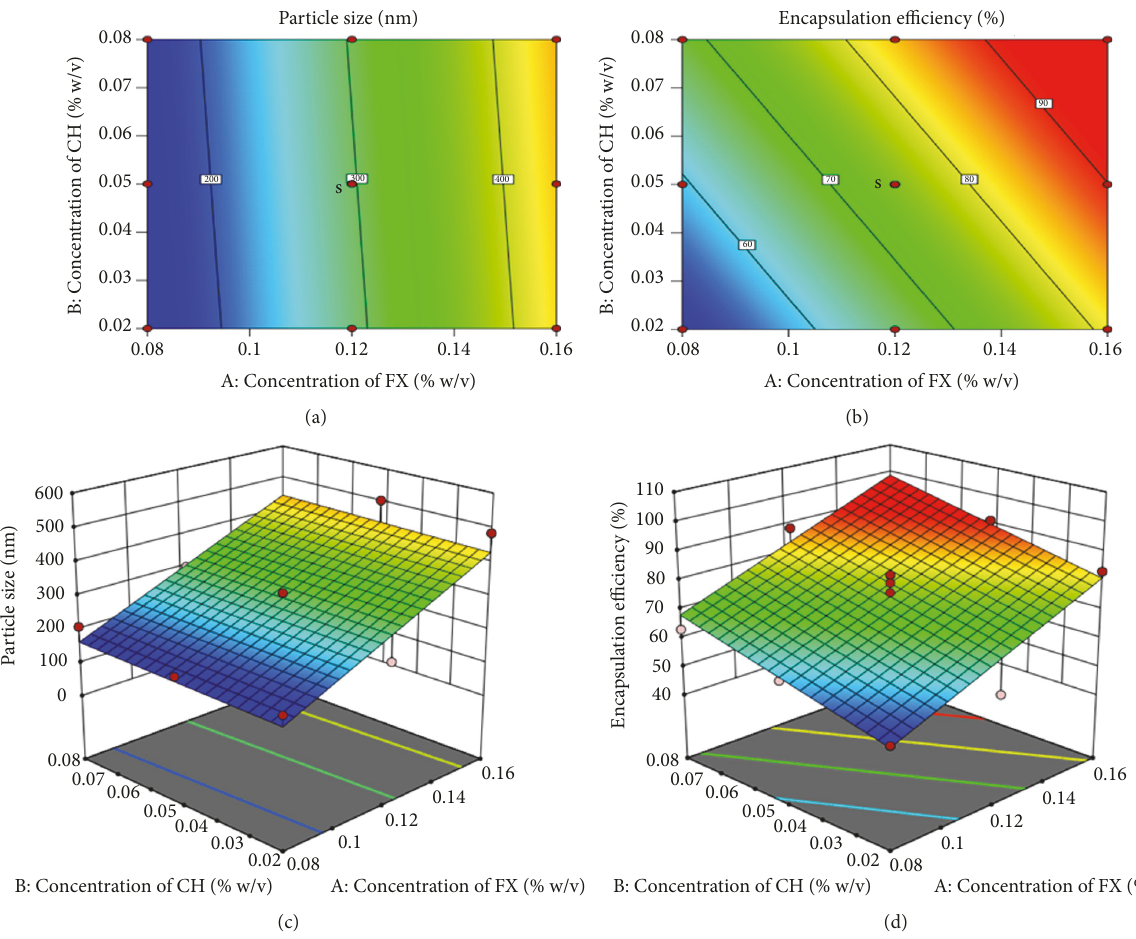
Figure 5: Response surface 2D and 3D contour graphs for particle size and encapsulation efficiency of FX-CH-TML nanoparticles.